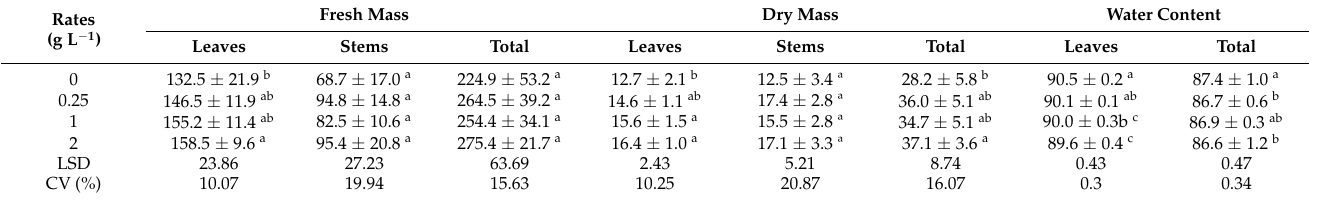
Table 3. Fresh mass (g), dry mass (g) and water content (%) of ora-pro-nobis plants treated with different L-arginine rates applied by